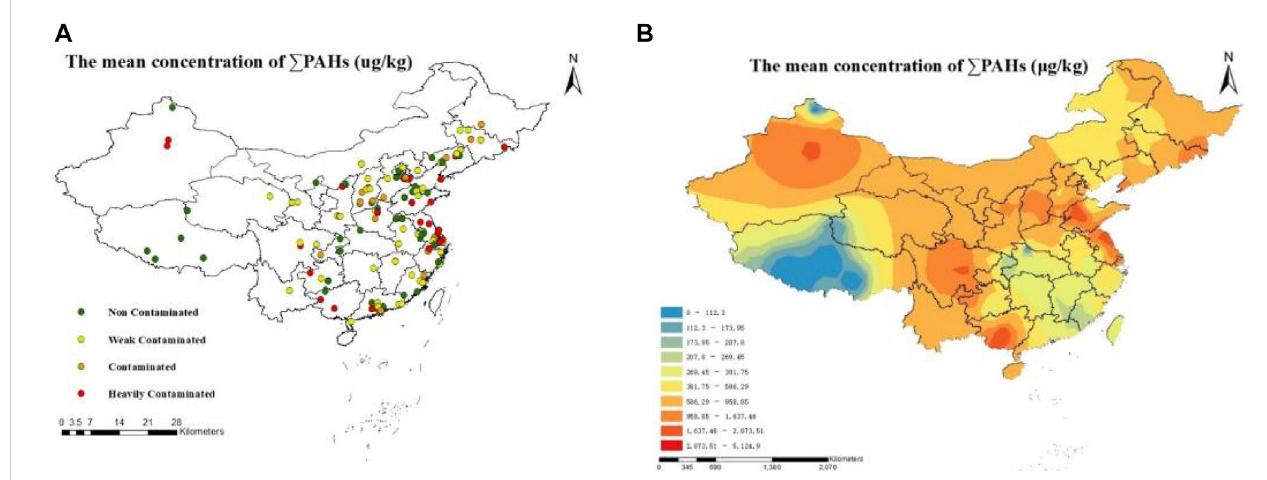
The spatial distribution of (cid:1) 16 PAHs concentrations in China from collected data [ (A) : sampling sites (B) : interpolation].